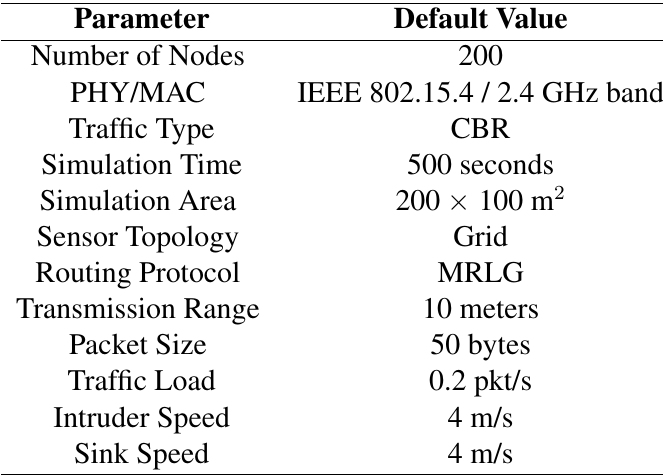
Table 1. Reference simulation